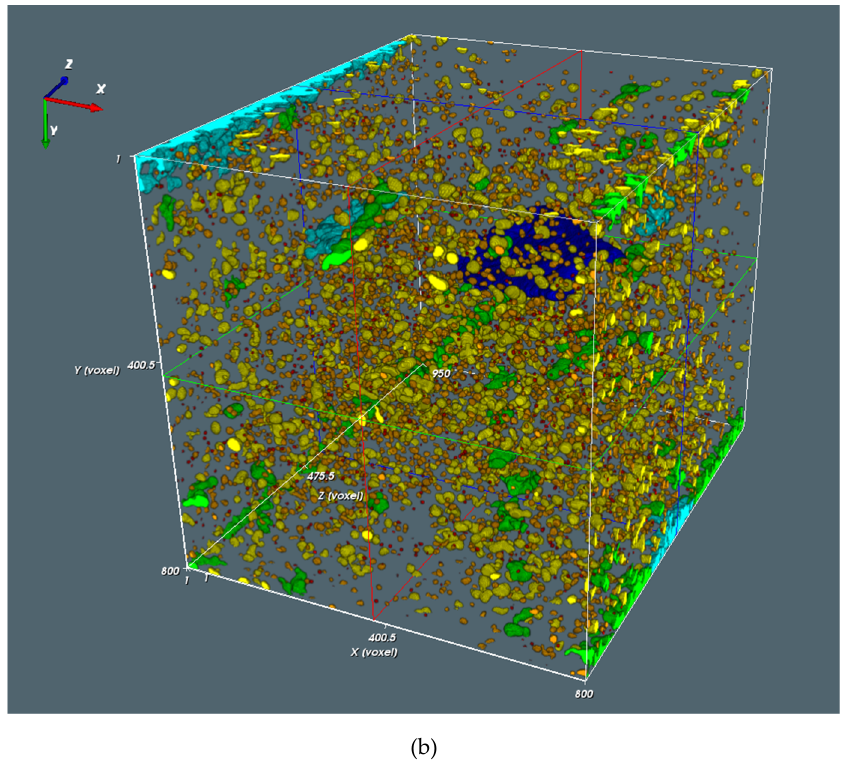
Figure 9. (a ) Object size classification for the sample Well-1(26). Colors: red: 1–99 voxels, orange: 100–999, yellow: 1000–9999, green: 10,000–9,9999, light blue: 100,000–999,999, dark blue: above 100,0000 voxels. ( b) Object size classification for the sample Well-2(7). Colors as in Figure 9a.